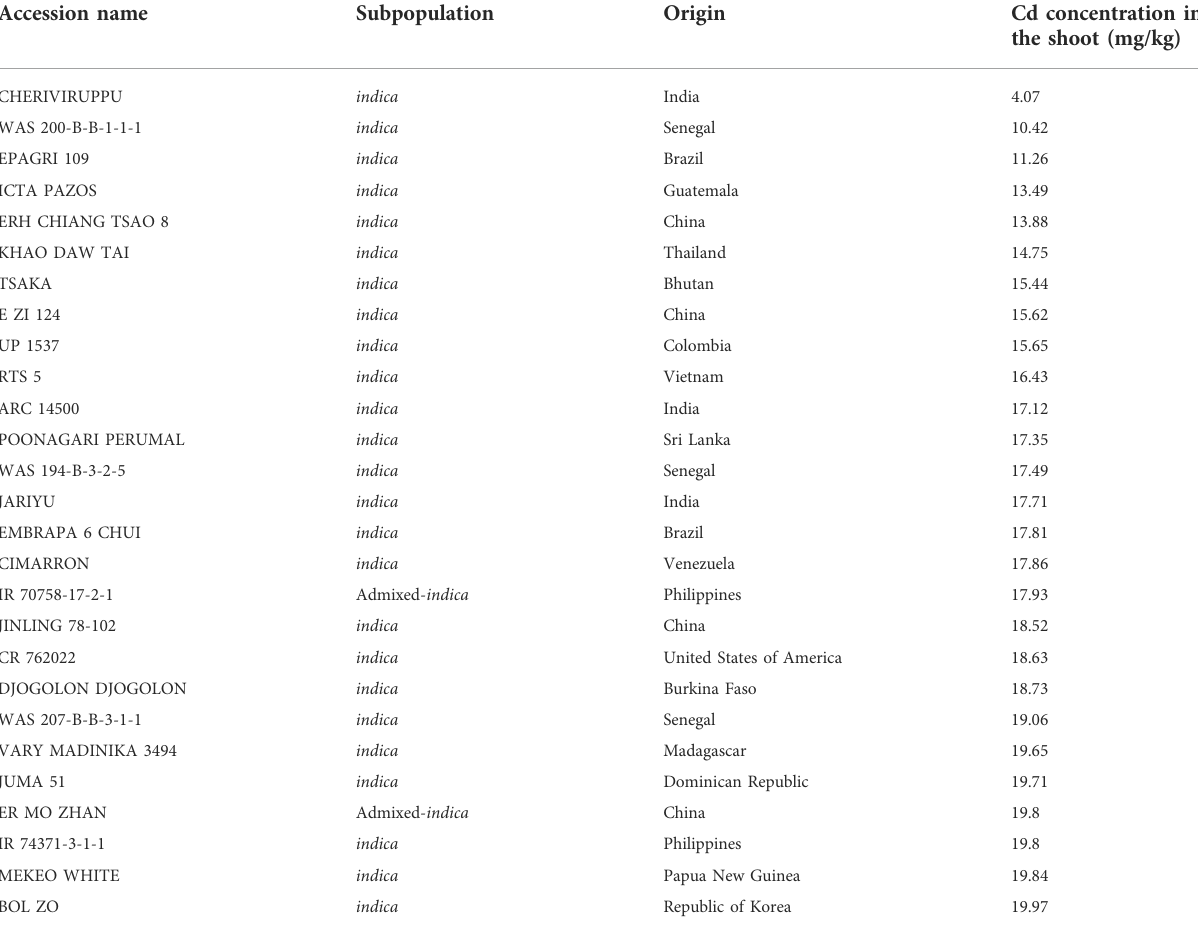
TABLE 1 Rice accessions with the Cd concentration lower than 20 mg/kg in the